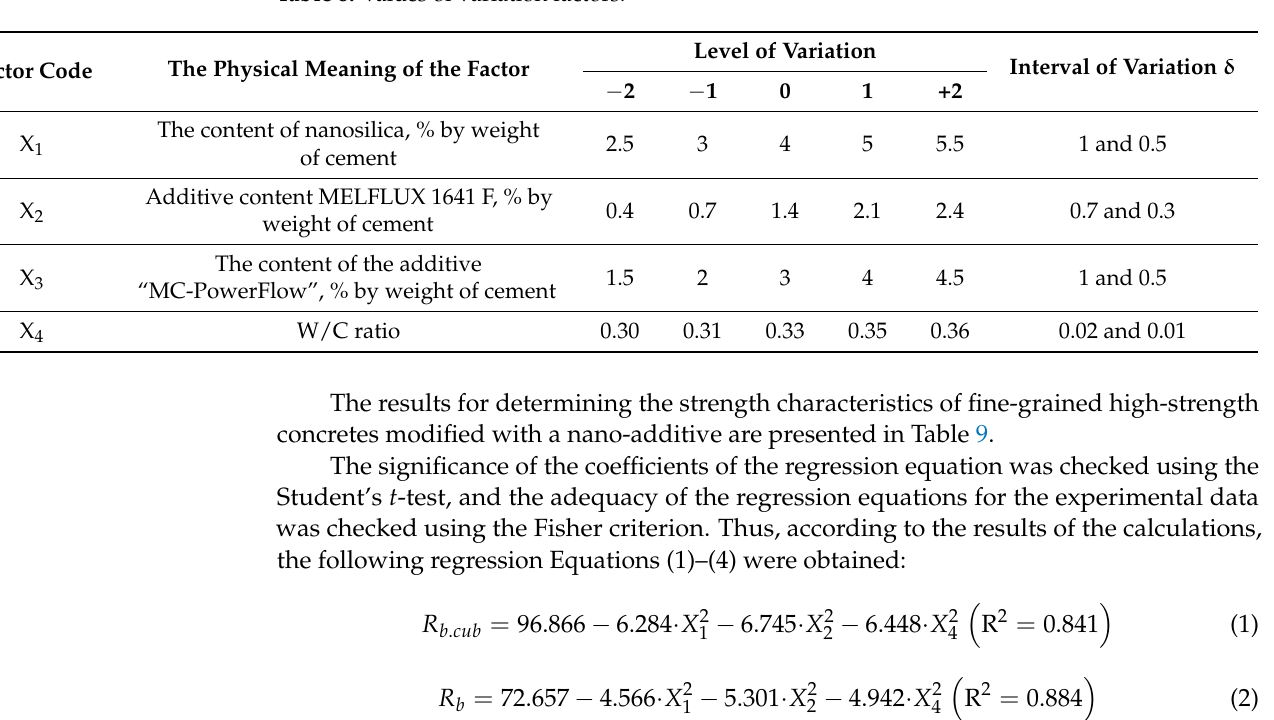
Table 8. Values of variation